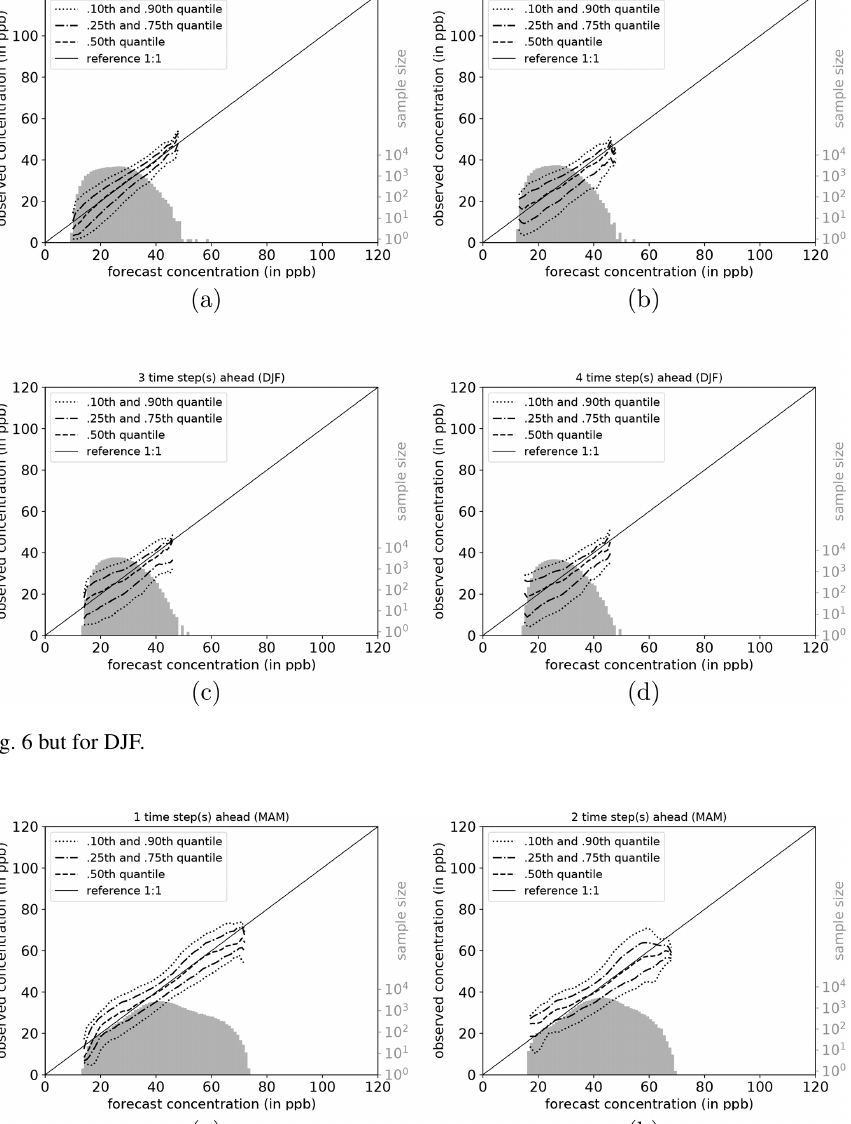
Figure A4. Same as Fig. 6 but for DJF.